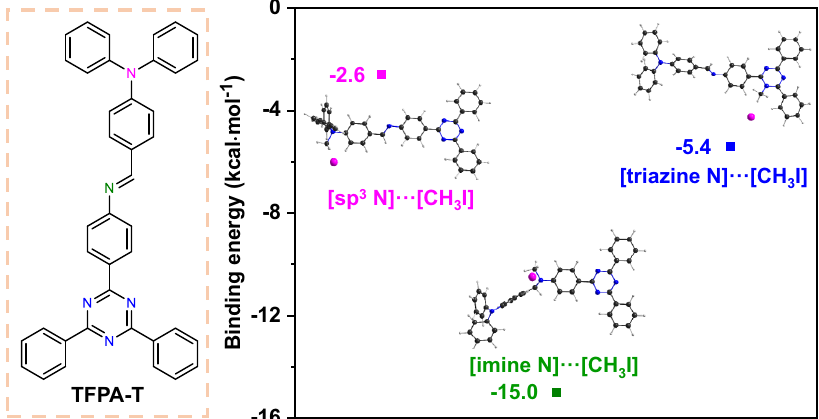
Fig. 7 Density functional theory calculations of the binding energies of CH 3 I with different N sites. TFPA-T is the model molecule used for calculations that represent COF-TAPT. In the molecular structure of TFPA-T (left panel), sp 3 N, imine N, and triazine N are labeled in pink, green, and blue,